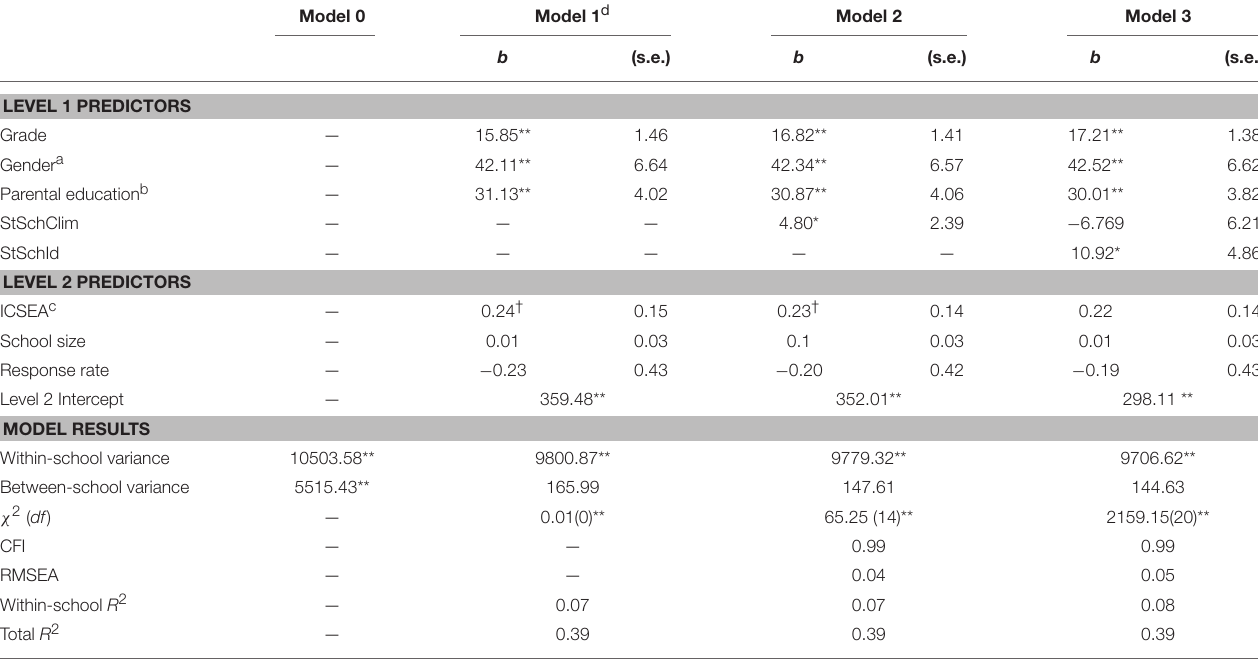
TABLE 7 | Multilevel SEM results for models 0–3 explaining NAPLAN